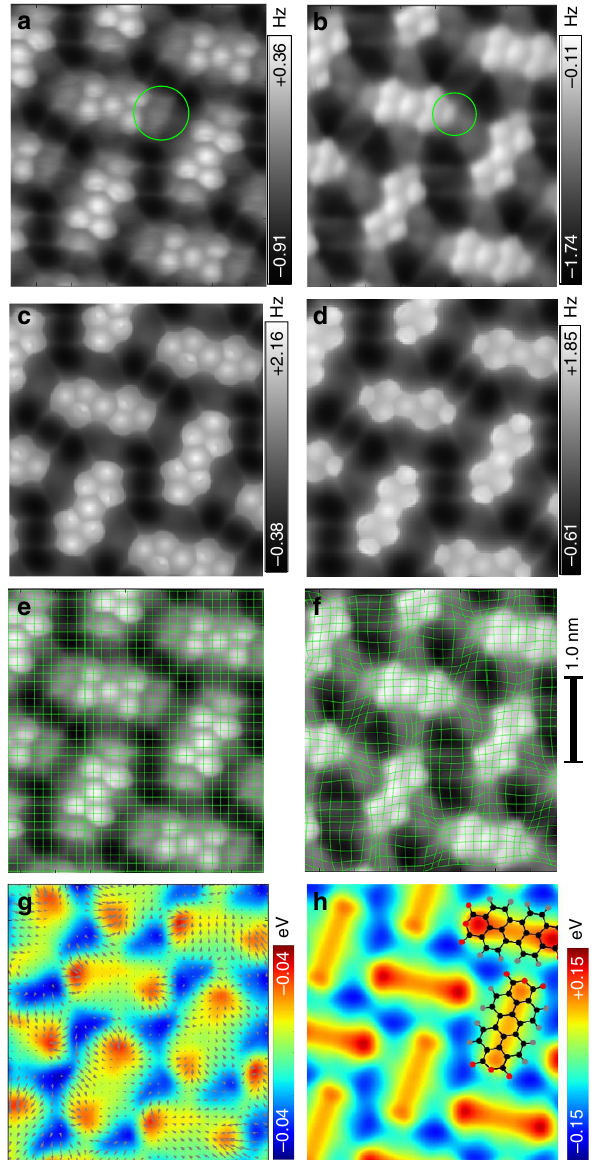
Figure 3 | Determining the electrostatic field above a close-packed PTCDA layer. ( a , b ) experimental high-resolution AFM images of a self- assembled monolayer of PTCDA deposited on Ag(111) obtained with two different Xe tips. ( c ) simulated AFM image using an effective charge Q ¼ 0.0e and the effective lateral stiffness k ¼ 0.16Nm (cid:2) 1 . ( d ) same as c but with Q ¼ þ 0.3e and k ¼ 0.20Nm (cid:2) 1 . ( e , f ) the experimental images superimposed with a deformation grid defined by comparing the corresponding sharp features between the two images in a and b . ( g ) electrostatic potential calculated from the deformation field (grey arrows). ( h ) calculated Hartree potential from DFTsimulations 3.0Å above the molecular layer.